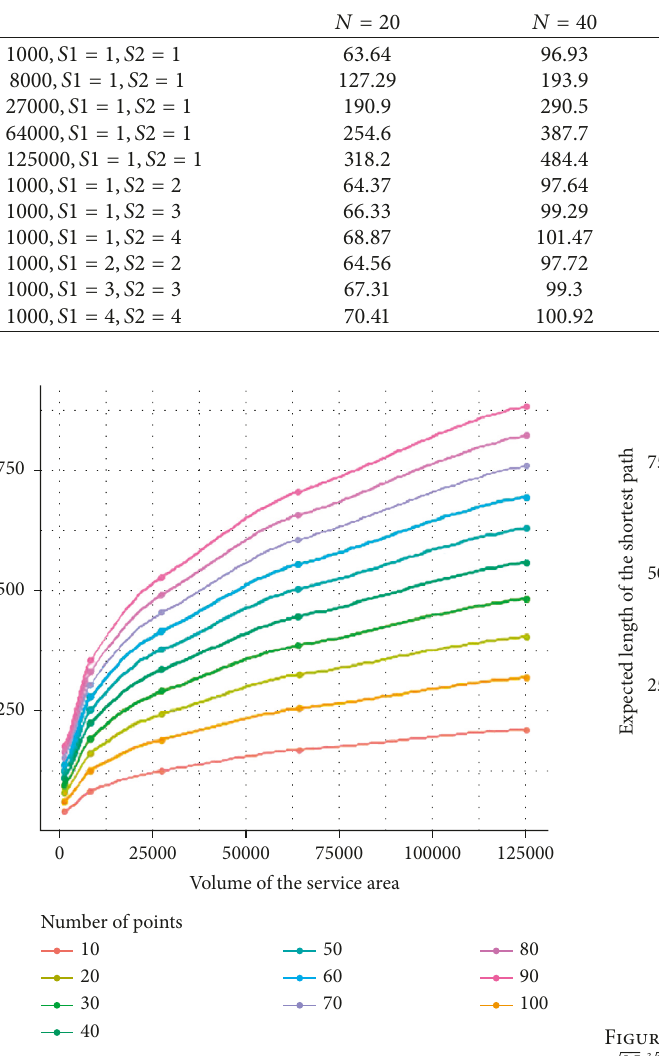
Figure 5: Relationship between the volume of the service area and the expected length of the shortest path under the different number of demand points ( s 1